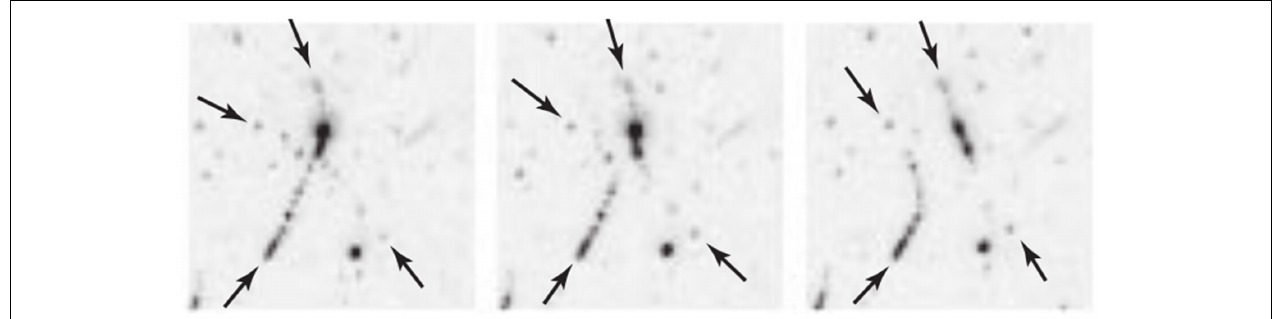
FIGURE 2 | Images of vortex reconnection in superfluid helium as visualized by hydrogen particles suspended in liquid helium at 50-ms time intervals. Reproduced with permission from Bewley et al. [17]. Copyright (2008) National Academy of Sciences, U.S.A.